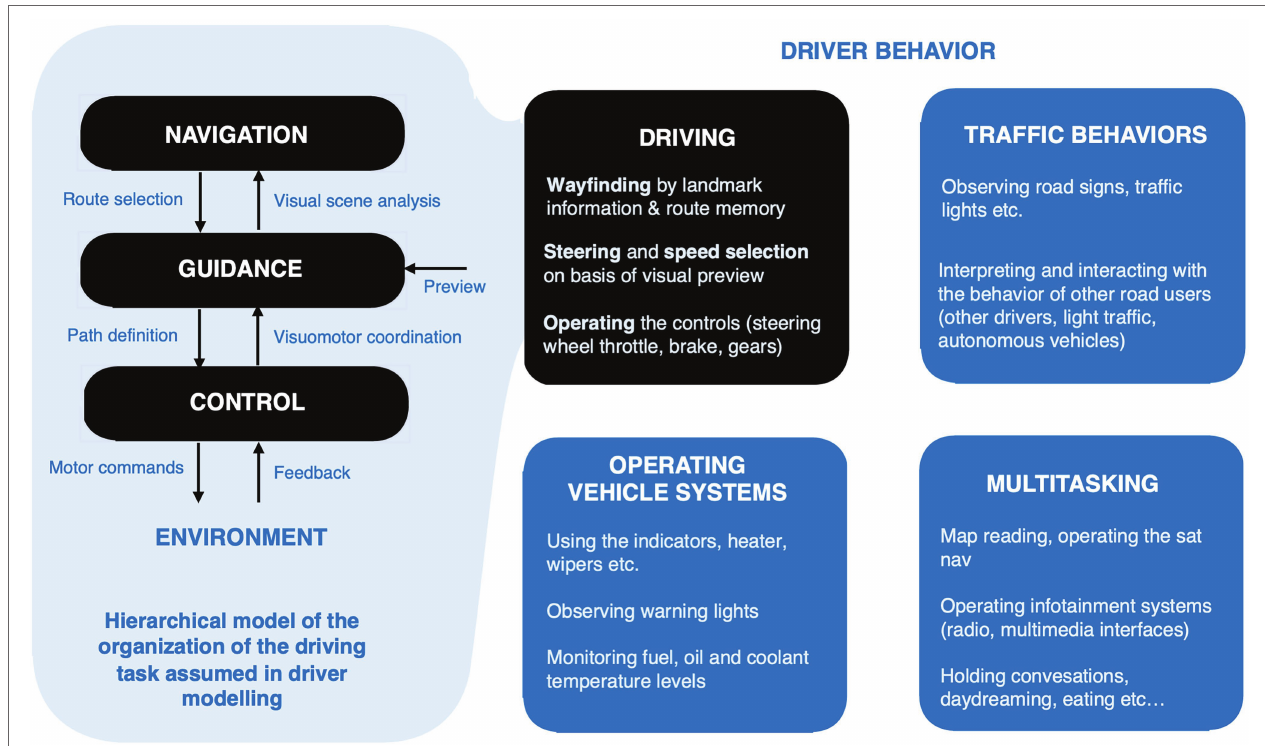
FIGURE 2 | Task structure of driving vs. driver behavior. While the driving task can be described in terms of steering and speed control and visual anticipation with gaze, it does not follow that the underlying brain processes compose in this way (e.g., separate steering and speed control “systems” or “modules,” or gaze strategies specific to steering and gaze strategies specific for speed